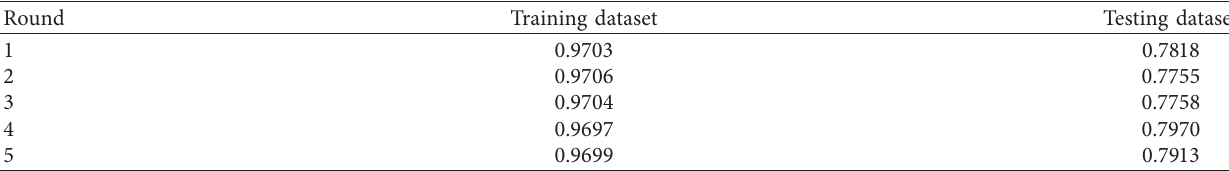
Table 6: R 2 from random forest regression.